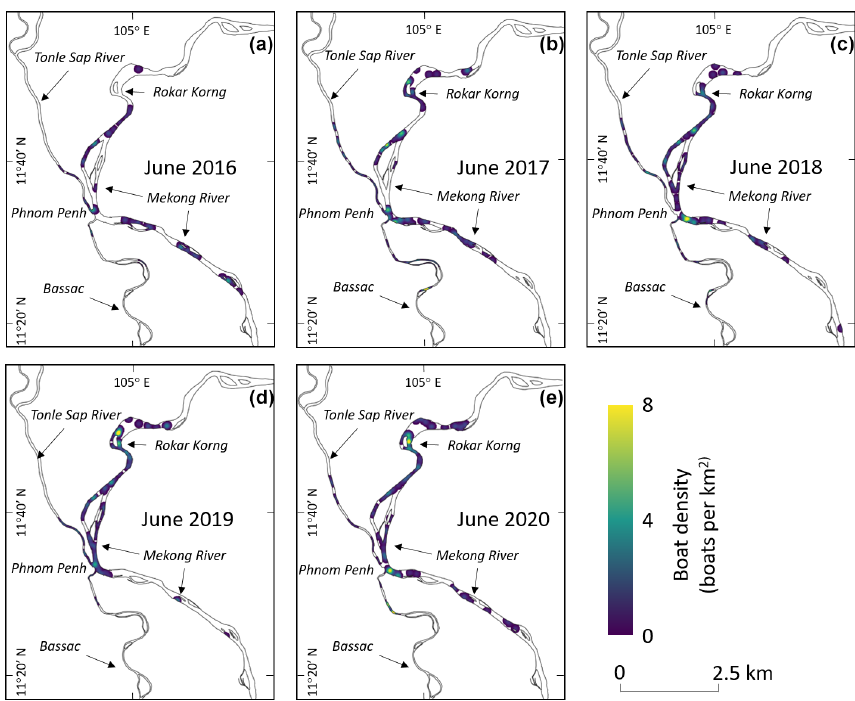
Figure 6. Annual heat maps for June for the period 2016–2020 of the Mekong River around Phnom Penh showing the locations of mining activity and the density of boats (boats per square kilometre) showing changes in the spatial distribution of mining activity over the 5-year